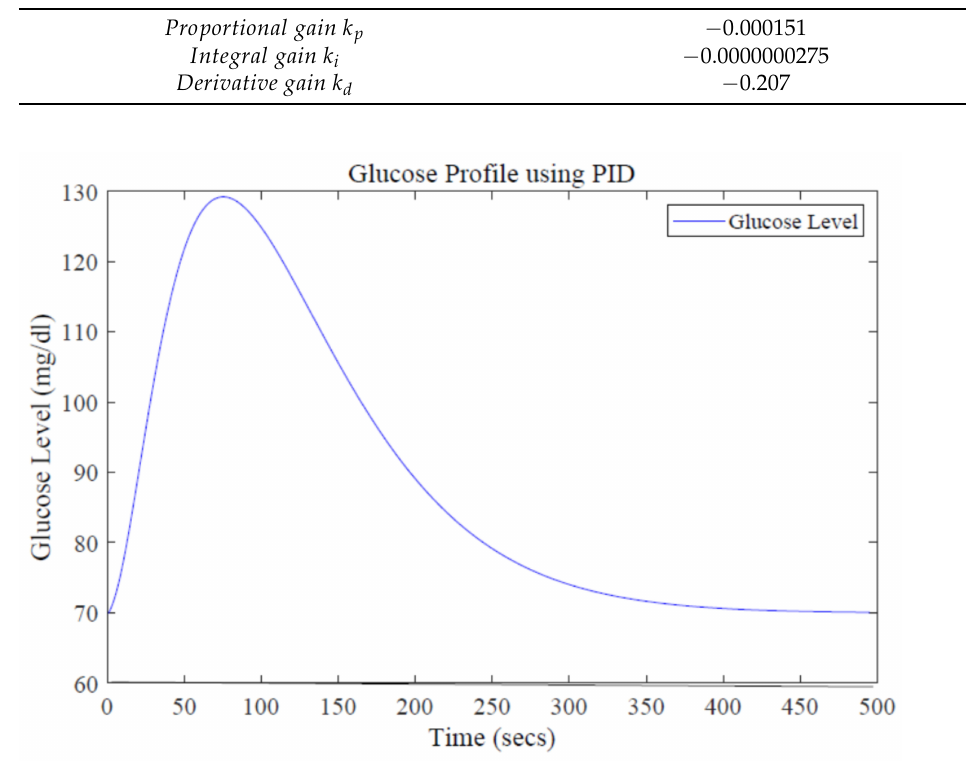
Figure 9. Glucose profile using the PID